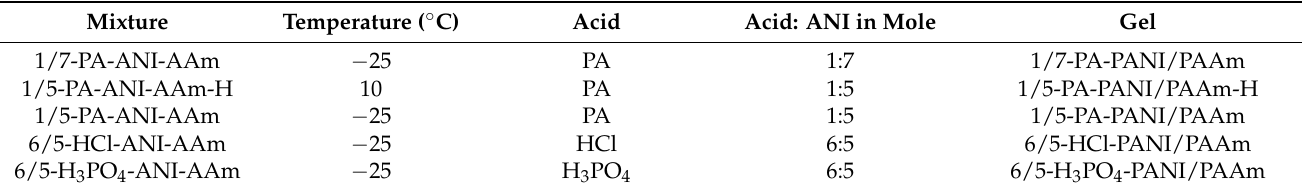
Table 1. Simultaneous polymerizations of AAm and ANI with different acids a